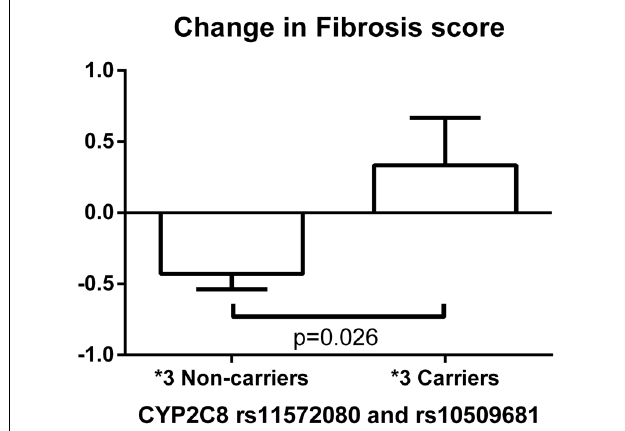
FIGURE 4 | Change in fibrosis score based on CYP2C8 ∗ 3 haplotype (rs11572080 and rs10509681) carrier status. The bar column and error bar represent the mean and the standard error of the mean